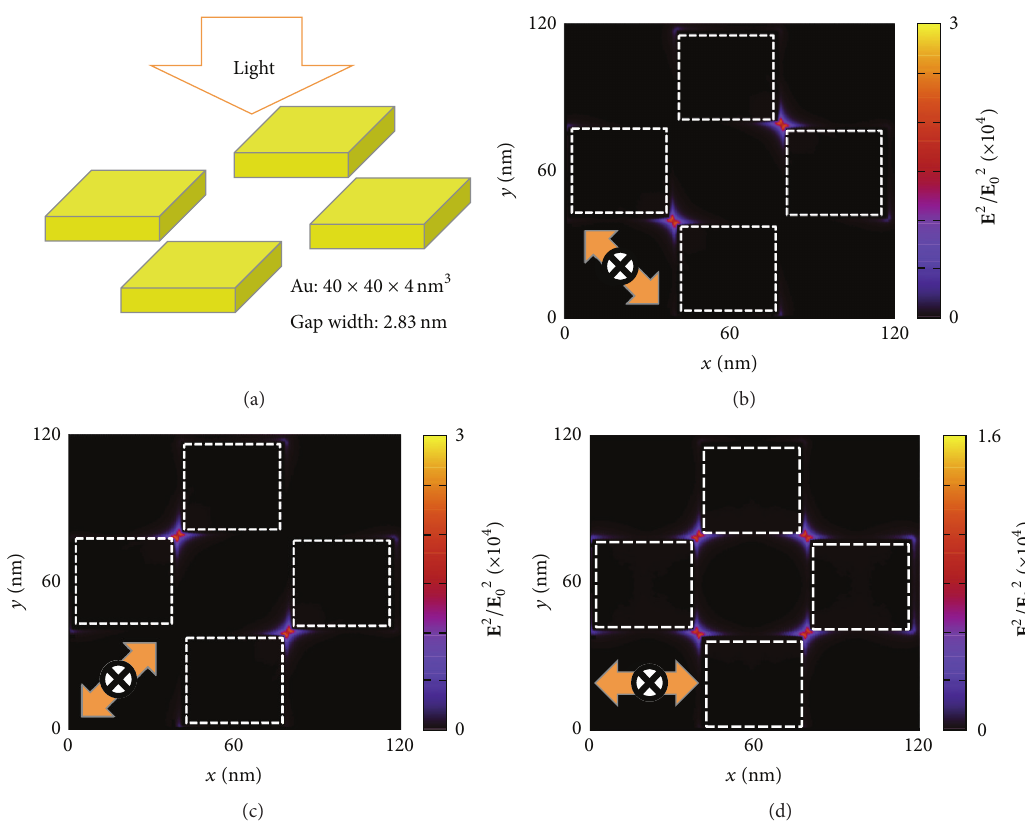
Figure 1: (a) Schematic figure of the metallic nanoblocks: we arrange four gold nanoblocks with a small spacing 2.83 nm; the size of each nanoblock is 40 × 40 × 4nm 3 . (b) The profile of the electric field intensity in the absence of the molecules: the two-way orange arrow indicates the direction of the polarization of the incident field; one can see that the total electric field is strongly enhanced at the spacing and produces “hot spots” for the molecules. (c, d) The profile of the total electric fields is plotted when the direction of the polarization is changed; one can see that the position and the intensity are changed with the